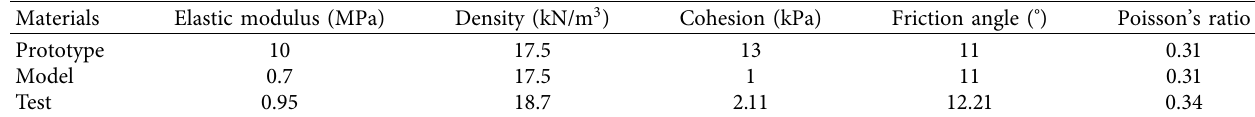
Table 14: Comparison of physical mechanical parameters for silt